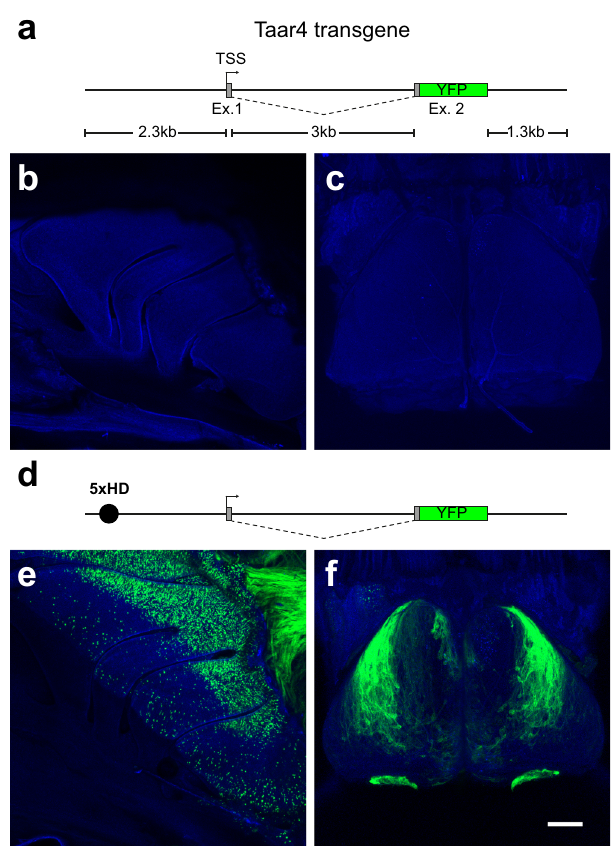
Fig. 1 TAAR4 transgene expression requires a strong OR enhancer. A transgene derived from the endogenous Taar4 locus is not suf fi cient to drive reporter expression. a Schematic of the transgene backbone in which the Taar4 coding sequence in exon 2 (Ex. 2) is replaced with that of YFP (green box). Non-coding regions shown in gray. De fi ned transcription start site (TSS) is indicated (arrow). b Confocal image showing a wholemount of the olfactory turbinates of a Δ T4-YFPtg mouse showing lack of labeled OSNs. c Confocal image showing a wholemount of the dorsal olfactory bulb showing no labeled axons. d Diagram of the 5xHD- Δ T4-YFPtg, in which a strong OR enhancer (5xHD; black circle) is placed upstream of the putative promoter. e Wholemount fl uorescence image of the olfactory turbinates showing robust expression of YFP in OSNs primarily in the dorsal olfactory epithelium. f YFP + axons of OSNs primarily innervate the dorsolateral olfactory bulb and accessory olfactory bulb. Scale bar in f = 500 µ m in b , c , e , and f (3) intergenic (i.e., outside known coding sequences, UTRs, or pseudogene fragments; Fig. 2a). To search for conservation, we used a combination of basewise sequence comparison (percent identity plots; PipMaker 42 between mouse and human, and the phyloP conservation track for 40 eutherian mammals in the UCSC database) (Fig. 2b). We identi fi ed two conserved intergenic regions that matched our criteria — one between Taar1 and Taar2 and one between Taar6 and Taar7a (Fig. 2b). These sequences were named T-elements 1 and 2 (TE1 and TE2), respectively.